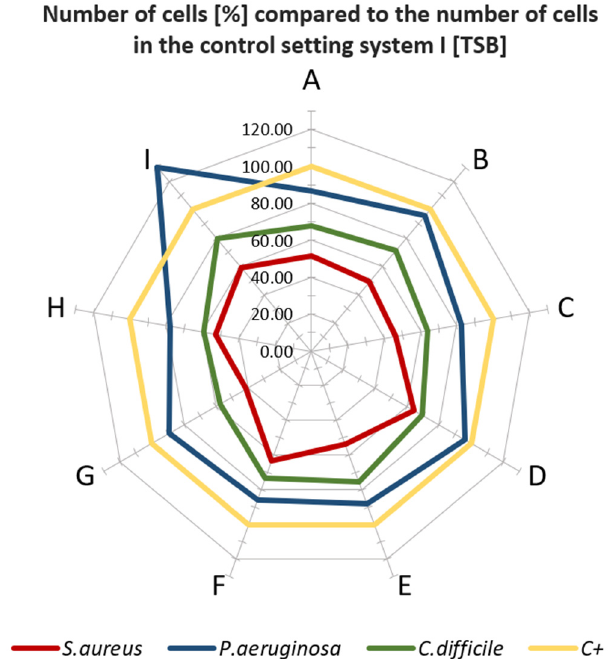
Figure 2. Plot of number of viable cells (%) on the surface of the test samples compared to the number of cells grown on the control surfaces in test setup I. Letters A–I: specific type of material applied.